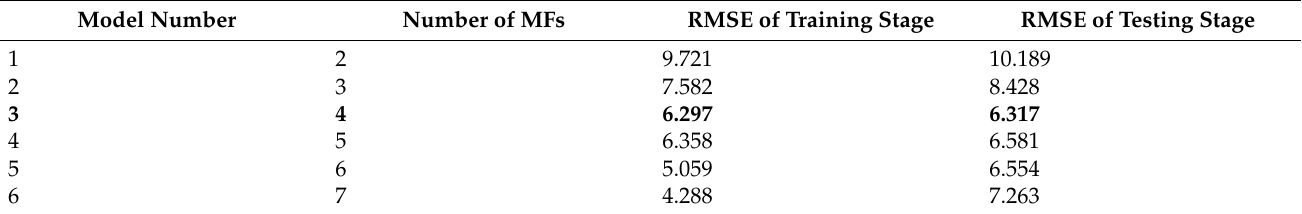
Table 3. Results of the trial-and-error process to determine the number of MFs in the ANFIS model.